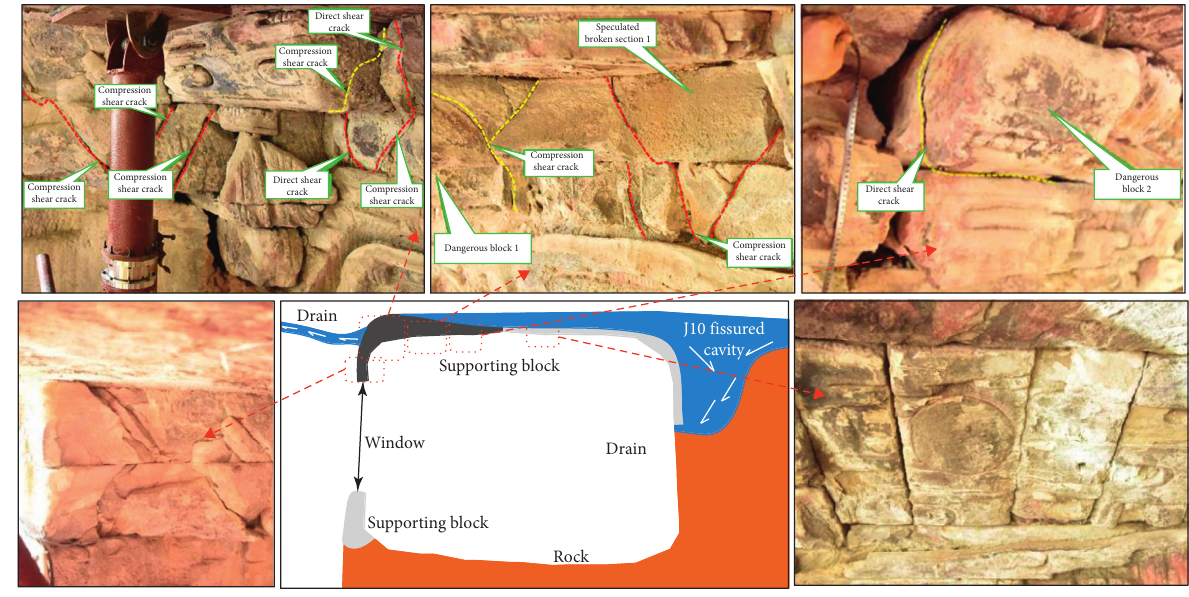
Figure 5: Breakage of supporting strips.